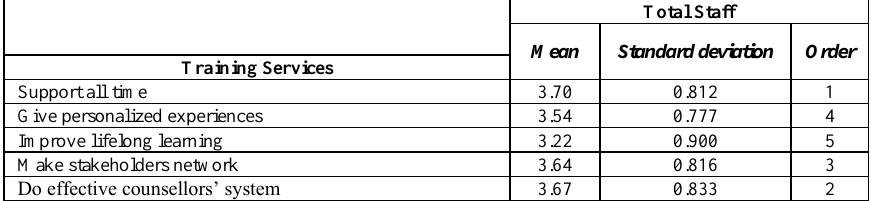
Table 4. Staff’s opinions about readiness in training services for HUST